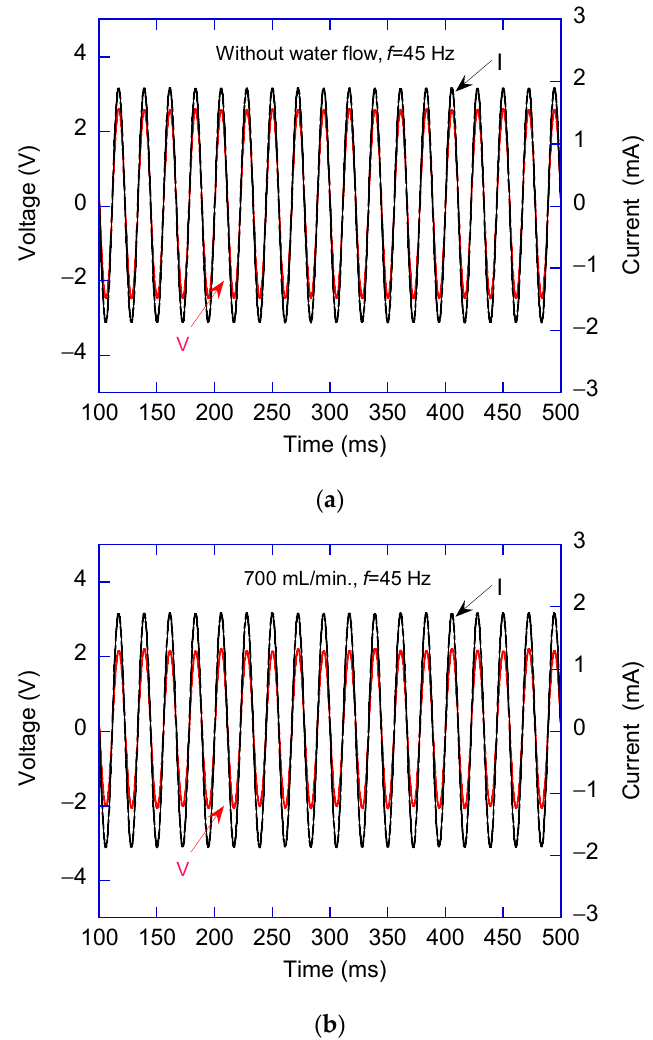
Figure 4. Waveforms of voltage (P1, P2) and sinusoidal current of 45 Hz applied to soil: ( a ) without water flow; ( b ) with water flow at a rate of 700 mL/min.